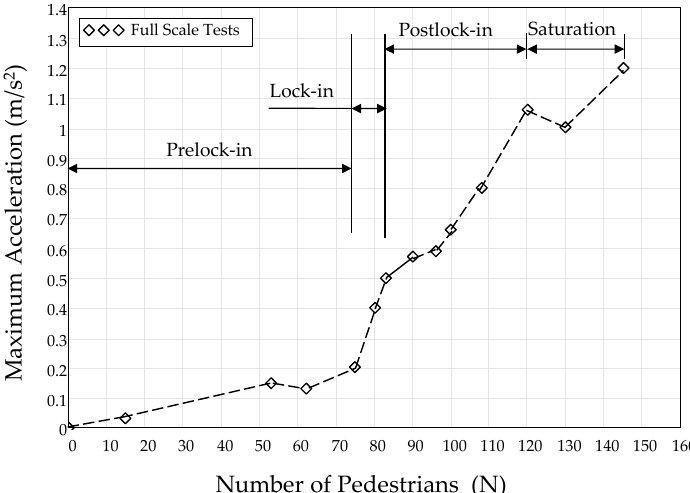
Figure 1. Full-scale crowd pedestrian tests on the Pedro e In ê s footbridge [18]. Maximum lateral acceleration response vs. number of pedestrians. Stages of lateral vibration response.